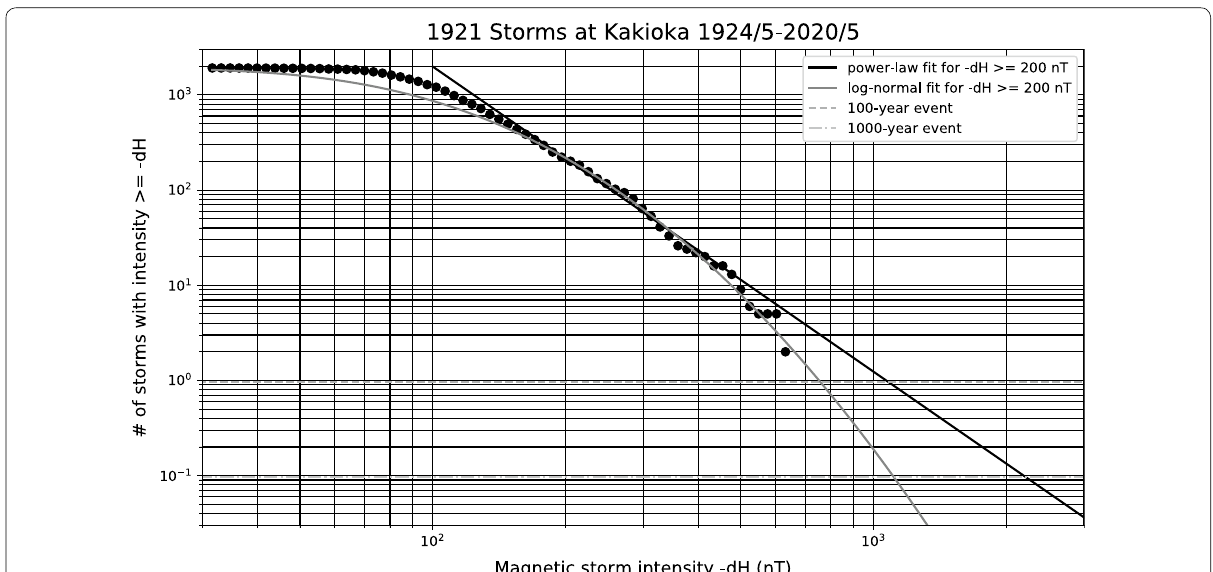
Fig. 3 Cumulative distribution function of 1921 magnetic storms observed at KAK for time interval May 1924 to May 2020. The data points are displayed at even intervals in logarithmic scale. Log-normal and power-law fits are shown by thick and thin solid curves, respectively. The best fitted parameters are α 4.2, μ 1.96, and σ = = =